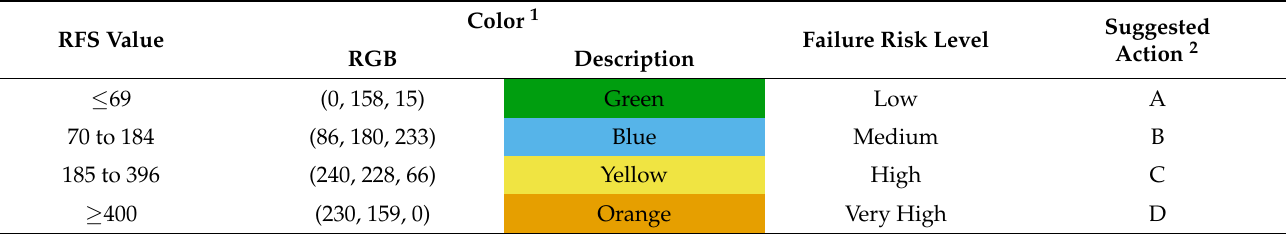
Table 7. Legend of the failure risk scores and linguistic